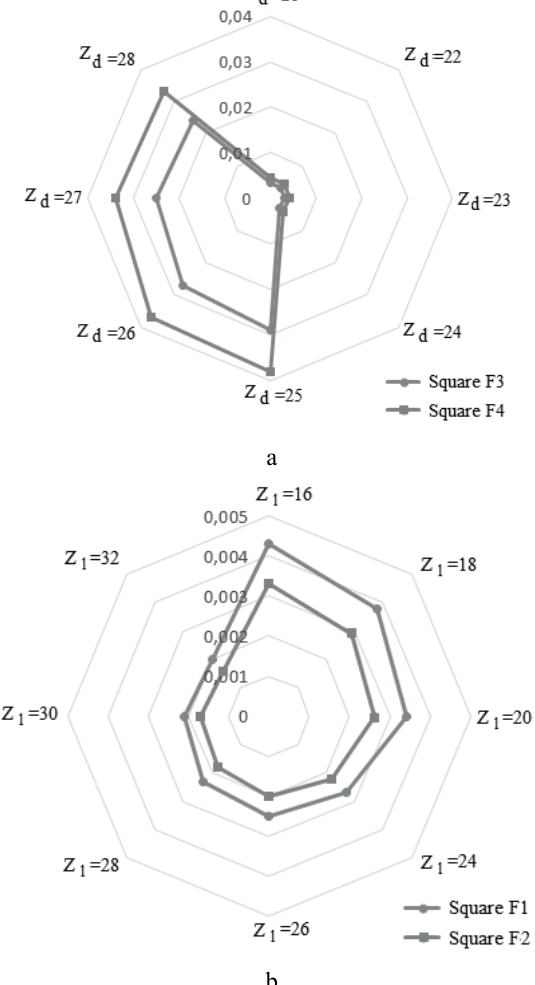
Fig. 7. Influence of the number of blades on the area of channels F 1 , F 2 , F 3 , F 4 : (a) with a fixed value of the impeller blades Z l = 26 and a variable value of the diffuser blades; (b) with a fixed value of the diffuser blades Z d = 22 and a variable value of the impeller